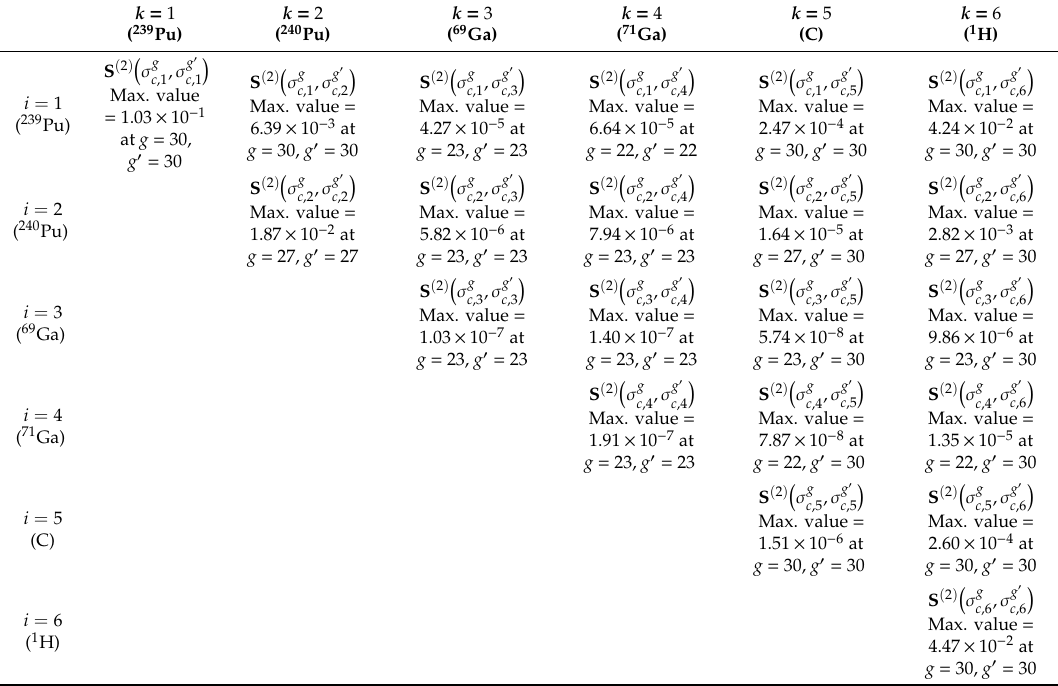
(cid:16) (cid:17) (cid:48) σ g , σ g , i , k = 1, ... ,6; g , g (cid:48) = 1, ... ,30. c , i c , k